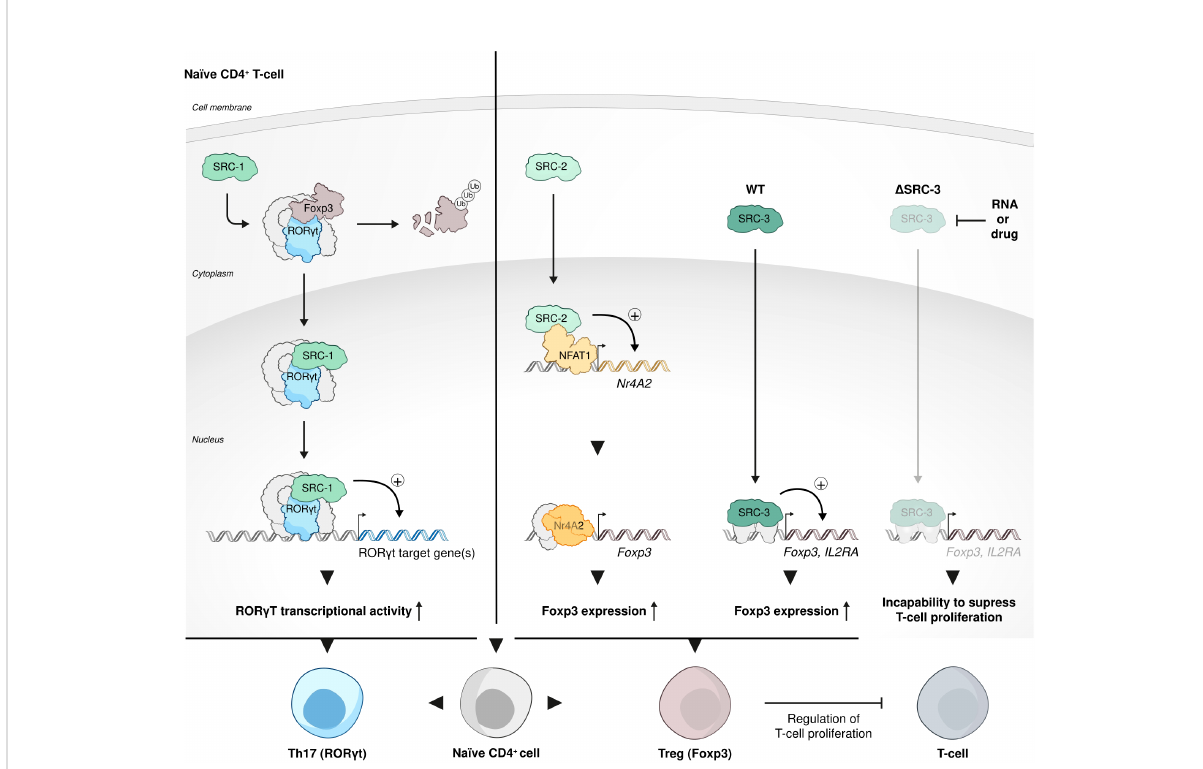
FIGURE 5 SRC-3 role in Treg cell biology function. Each one of the three SRCs has a distinct role in Treg cell biology and function. SRC-1 replaces FOXP3 in its interaction with ROR g t to shift phenotypic dominance of CD4 cells from Treg cell to Th17 cells; SRC-2 stimulates Treg cell differentiation from naïve CD4+ T cells by coactivating NFAT1 to force the expression of a FOXP3 regulator Nr4a2; SRC-3 is enriched and critically important to the biological function of Tregs: inhibition of SRC-3 results in a decrease of transcript levels of the signature Treg cells genes - FOXP3 and IL2RA and consequent incapability of these Tregs to suppress proliferation of conventional T